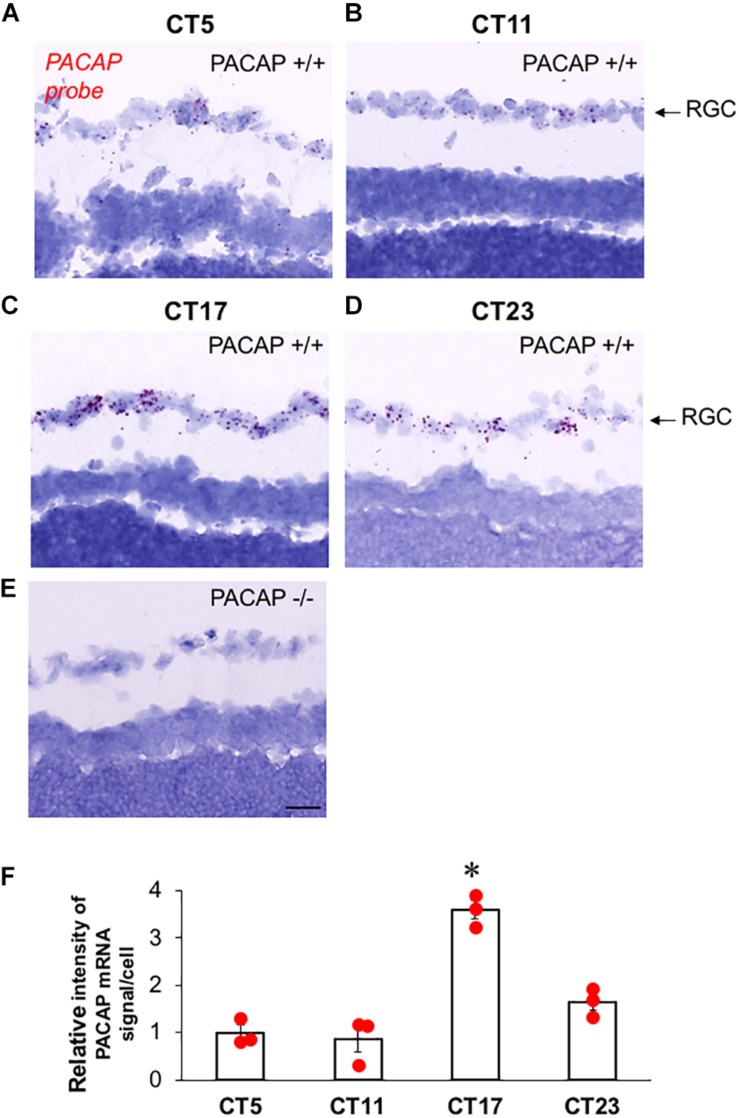
PACAP mRNA expression in ipRGCs of C57Bl6 mice during late subjective night, and mid-subjective day. (A–D) Representative photomicrograph of sagittal section from wild-type (PACAP+/+) C57Bl6 mouse retina at CT5–CT23 with PACAP transcripts (red) in retinal ganglion cell (RGC) layer. (E) Representative photomicrograph of sagittal section from PACAP KO (PACAP–/–) mouse retina at CT23 with invisible PACAP transcripts in RGC layer. (F) Relative expression level of PACAP mRNA in RGC at CT5, CT11, CT17, and CT23. The scatter plot was from three animals per time point. The box and error bar represent mean ± SEM. One-way ANOVA followed by post hoc Bonferroni analysis: ∗p < 0.01, CT17 compared to CT5, CT11, or CT23. Scale bar: 25 μm.